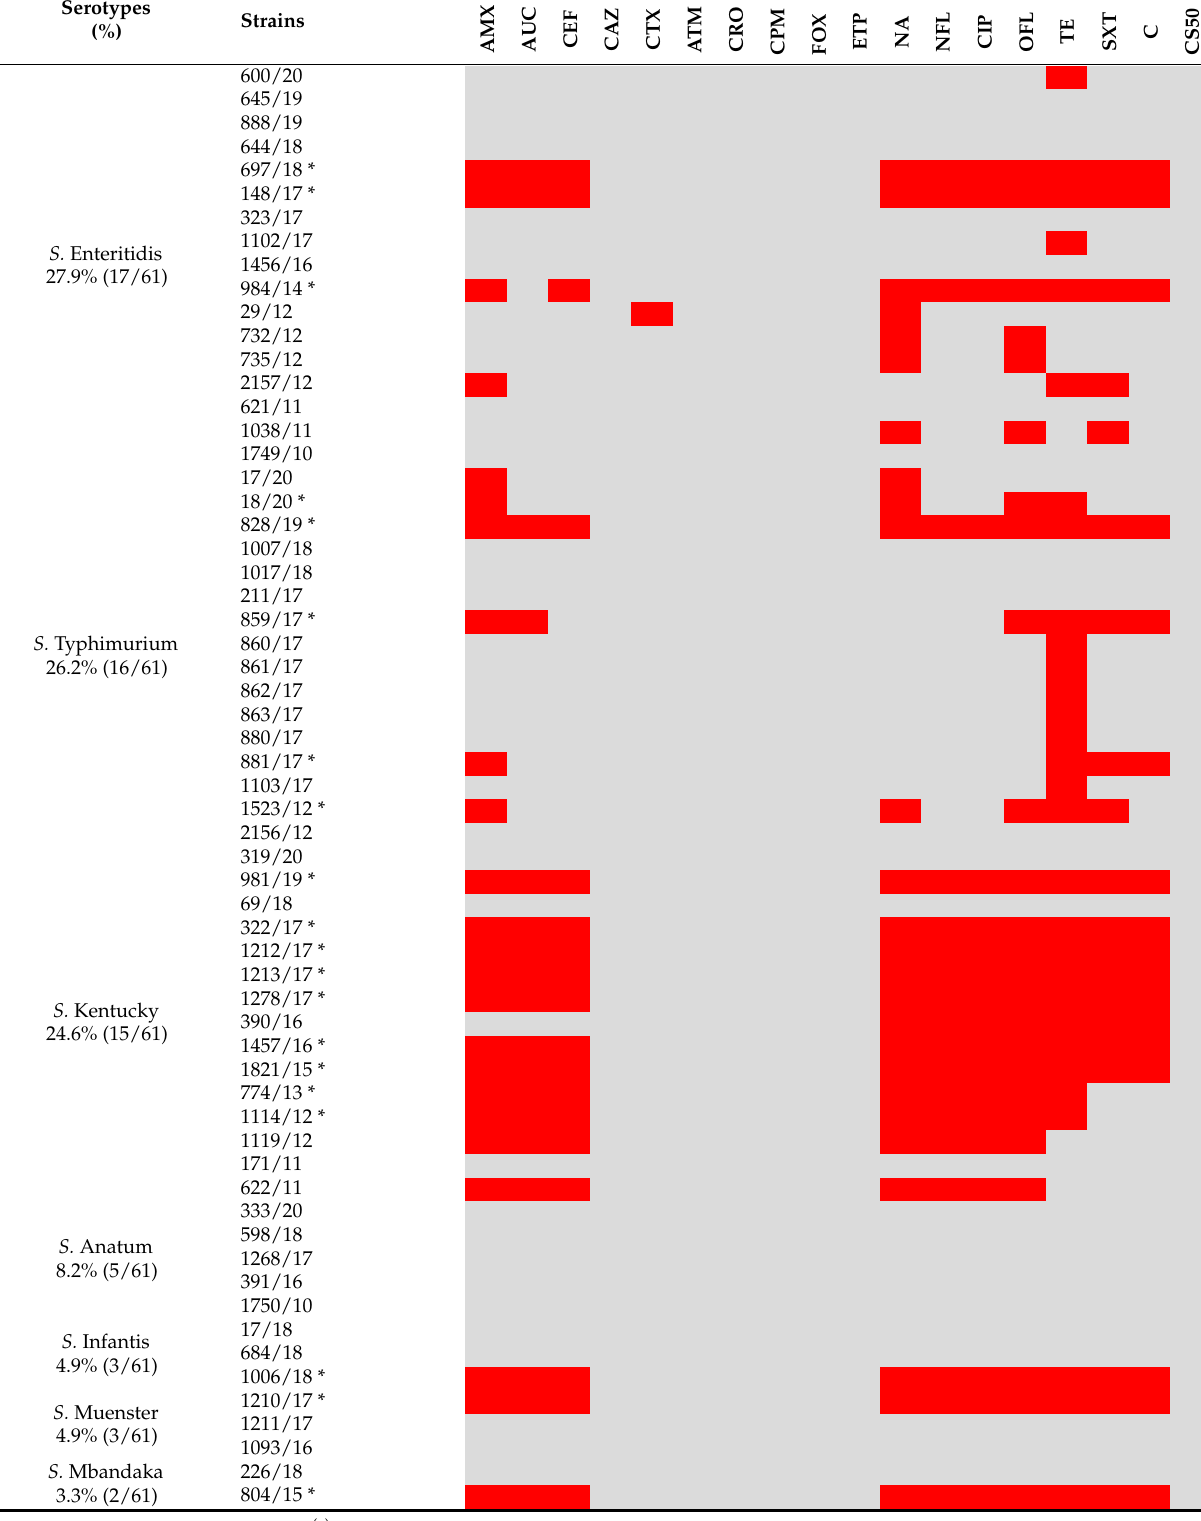
Figure 1. Antimicrobial-resistant percentages in Salmonella strains isolated from hospitalized pa- tients with gastroenteritis in Great Tunisia between 2010 and 2020. AMX: Amoxicillin, AUC: Amox- icillin + Clavulanic acid, CEF: Cefalotin, FOX: Cefoxitin, CAZ: Ceftazidim, CTX: Cefotaxim, CRO: Ceftriaxon, CPM: Cefepim, ATM: Aztreonam, ETP: Ertapenem, GME: Gentamicin, CS50: Colistin, NA: Nalidixic acid, OFL: Ofloxacin, CIP: Ciprofloxacin, NFL: Norfloxacin, C: Chloramphenicol, TE: Tetracycline, SXT: Trimethoprim-Sulfamethoxazole and AMK: Amikacin. In addition, 40% (24/61) of the isolated strains were susceptible to all antibiotics used and 33% (20/61) were multidrug-resistant (MDR). Moreover, 80% (12/15) and 60% (9/15) of S . Kentucky isolates were identified as fluoroquinolone-resistant and MDR strains, re- spectively (Table 2, Figure 2). 010